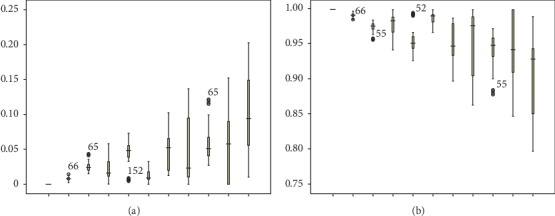
A boxplot of the proportion of (a) Q1 and (b) Q2 varying with ξ.